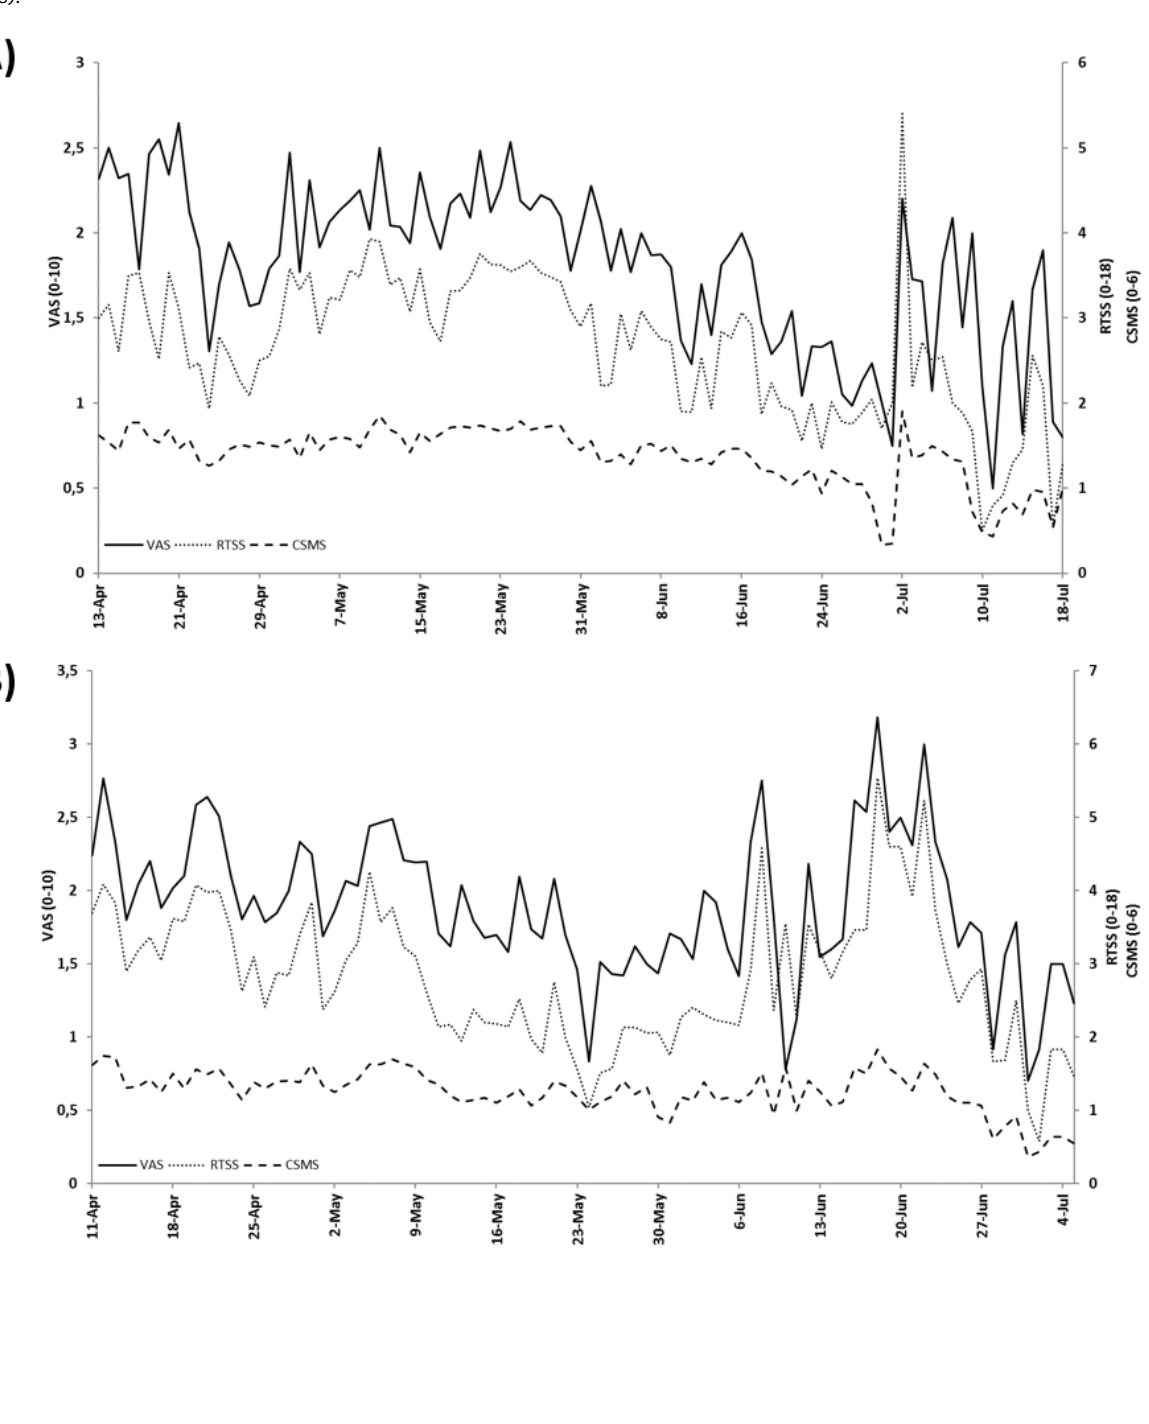
Figure 5. Mean visual analog scale (VAS) score, Rhinoconjunctivitis Total Symptom Score (RTSS), and combined symptom and medication score (CSMS) by time considering the local whole season of grass pollen in (A) Rome (n=101) and (B) Pordenone (n=93; see Figure 2 and Table 2 for